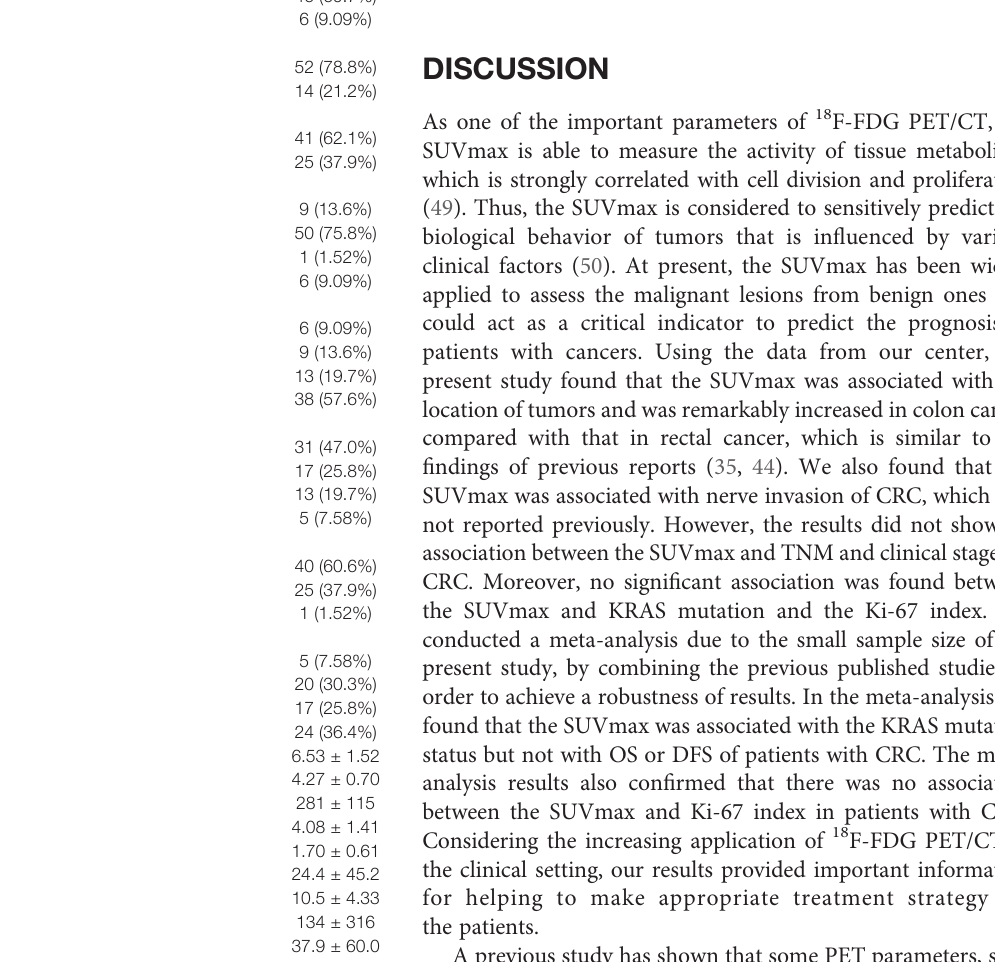
Random effect method, I 2 : 66%, p heterogeneity: 0.01; Figure 6A ). No signi fi cant publication bias was observed